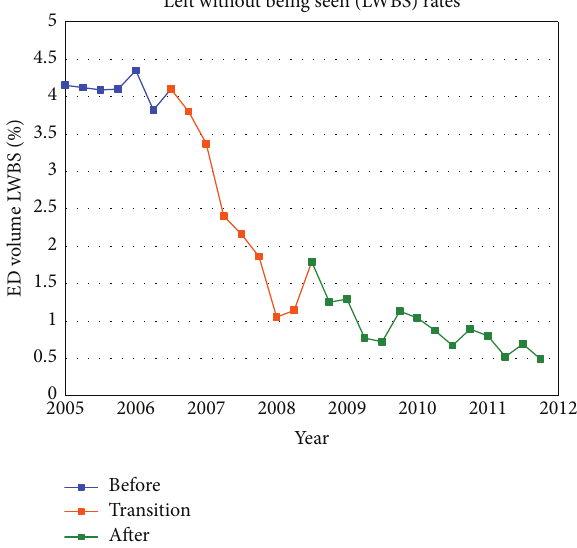
Figure 7: Left without being seen (LWBS) rate: percentage of patients who arrived at the ED but then left without receiving medical